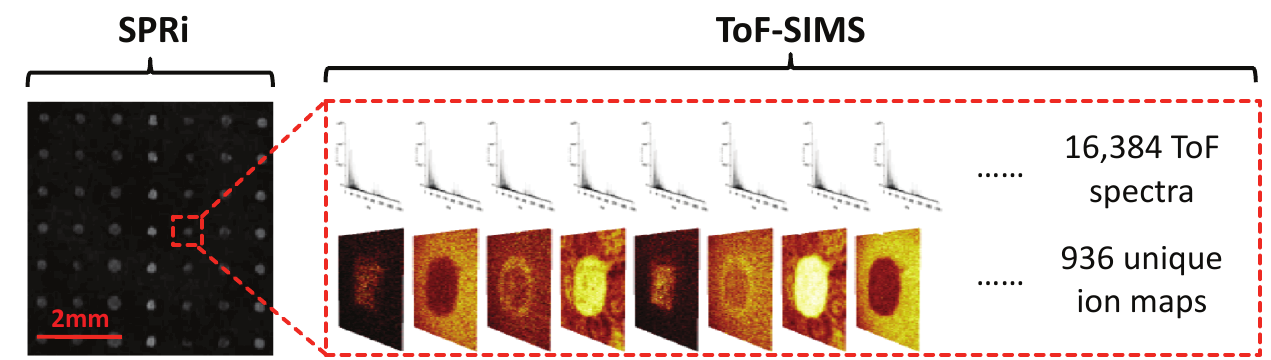
Figure 2. ToF-SIMS imaging analysis of a printed carbohydrate microarray—SPRi image (left) illustrates a carbohydrate-binding protein adsorbed to a printed glycan array; ToF- SIMS image analysis (right) represents acquisition of SIMS data from a printed spot. A 500 × 500 μ m area (centered on an array spot) is rastered by a primary ion beam, generating 16,384 mass spectra, each corresponding to a ~3.9 × 3.9 μ m pixel. These mass spectra can be combined to create ion maps (images) displaying the spatial abundance of each observed ion. In the case of the carbohydrate microarray, 936 unique ions were observed in a representative spot on the